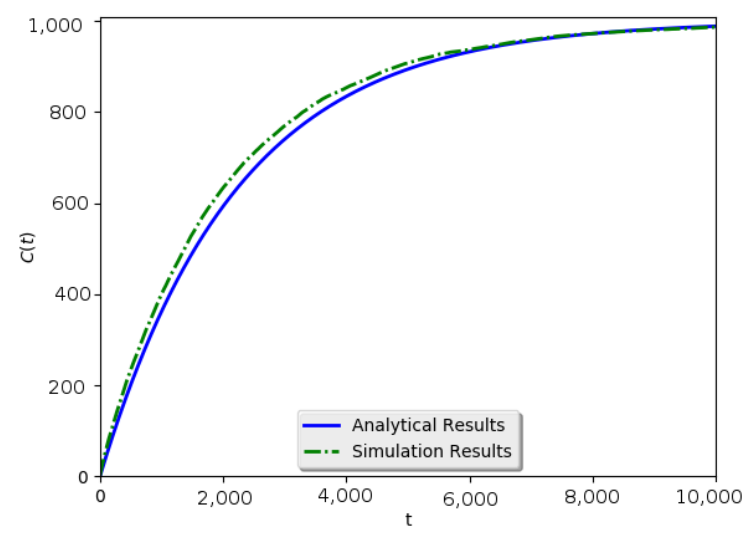
Figure 7. Simulation results for 100 sparse networks with number of nodes N = 1000, radius r c = 0.06 and mean number of neighbors = 12. One can see that the simulation’s outcome is in accordance with the expected results from the analysis.